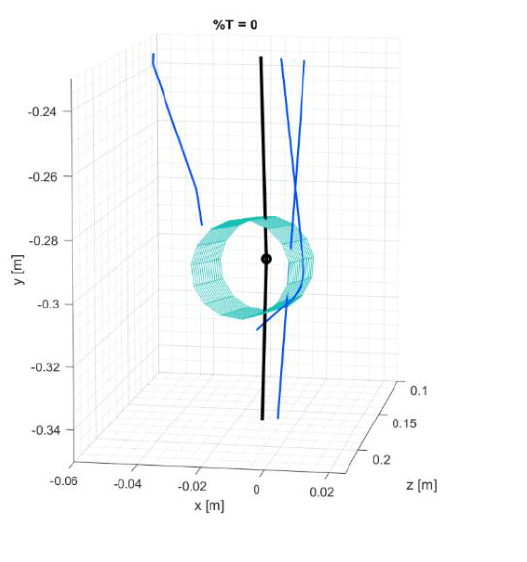
Figure 12. Muscles’ fiber lengths comparison: ( a ) Matlab ( a ) and ( b ) OpenSim.